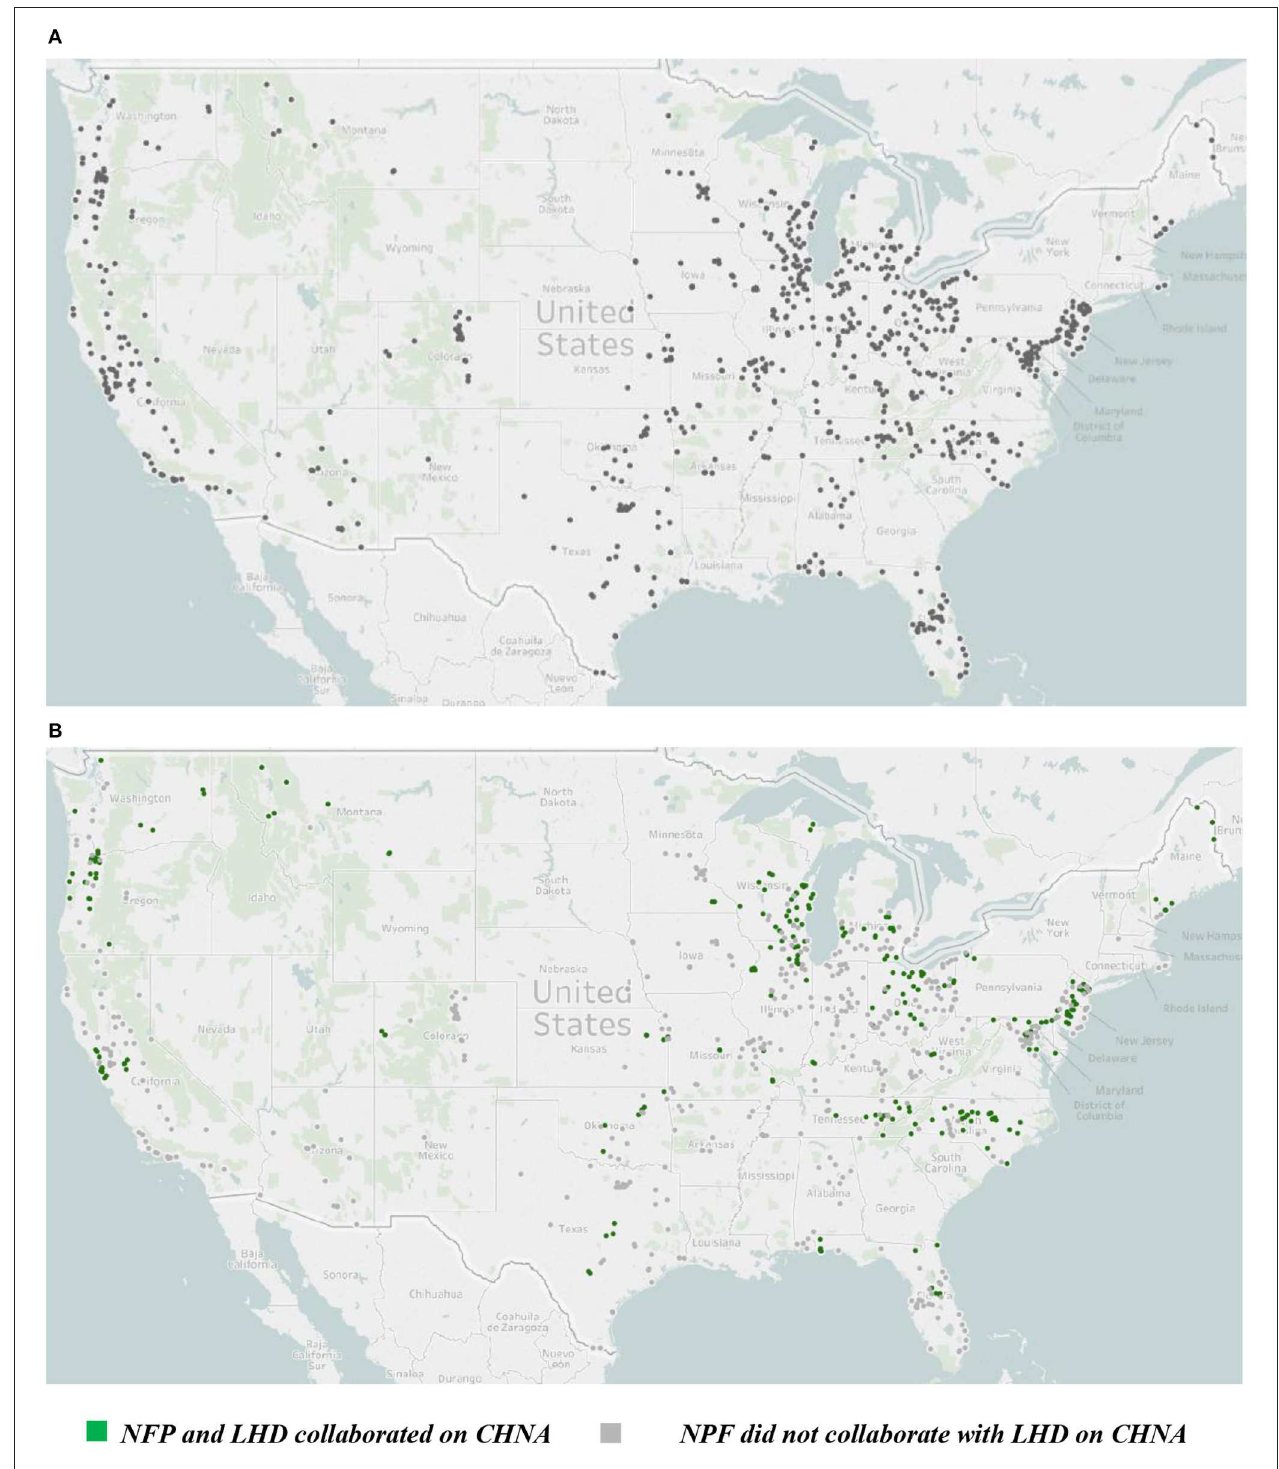
FIGURE 1 | (A) Geographic distribution of sample non-profit hospitals. (B) Geographic distribution of sample non-profit hospitals: by status of collaboration with local health department. Authors’ analysis of data from the IRS, Centers for Medicare and Medicaid Services, and non-profit hospital (NFP) community health needs assessments (CHNA) and implementation